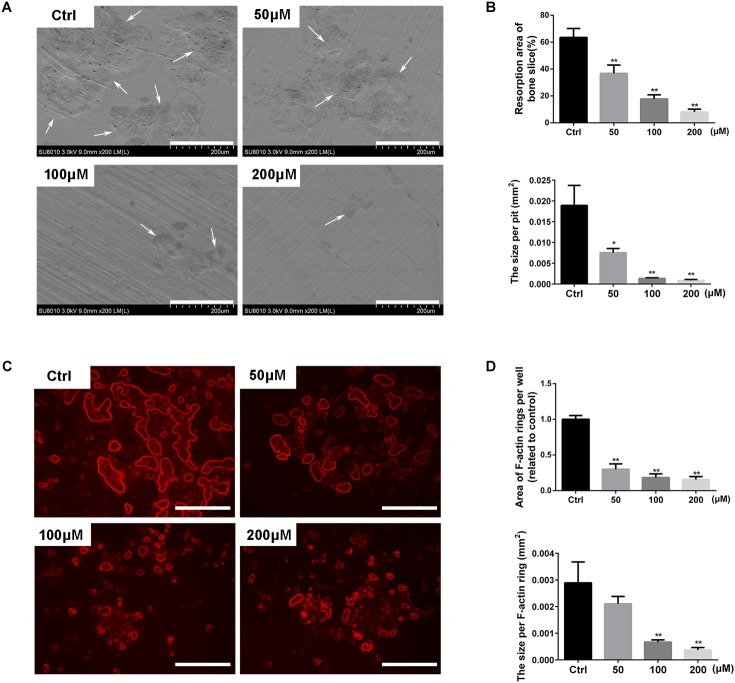
Stevioside inhibits bone resorptive activity of mature osteoclasts. An equal number of BMM-derived mature osteoclasts were seed onto bovine bone slices and treated with indicated concentrations of stevioside for another 2 days. (A) Representative scanning electron microscopy (SEM) images of bone resorption pits. Scale bars = 200 μm. (B) The resorption area of bone discs was measured using ImageJ. (C) Representative fluorescence images of F-actin staining with rhodamine-phalloidin. Scale bars = 200 μm. (D) The area of F-actin rings was measured using ImageJ. Data are presented as mean ± SD. ∗P < 0.05, ∗∗P < 0.01, compared with the controls.